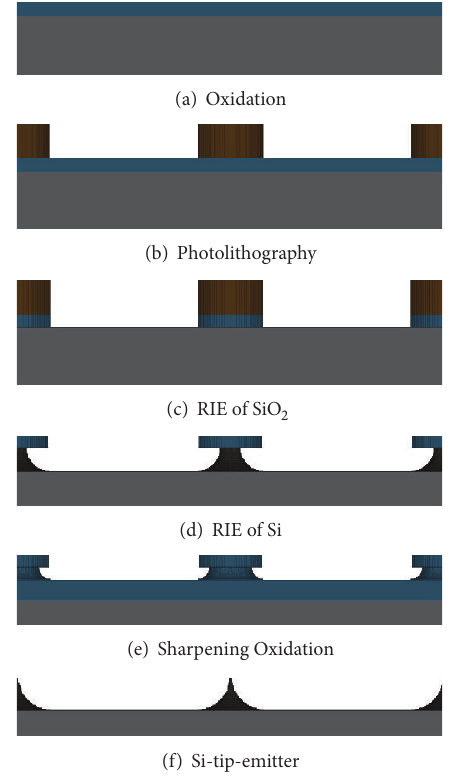
Figure 2: Schematic of the structured cathode fabrication process (simulated with IntelliSuite). (a) Thermal growth of SiO 2 layer. (b) Photolithography with AZ5214. (c) Transferring of the structures into SiO 2 by reactive-ion etching. (d) Reactive-ion etching of the bulk Si. (e) Sharpening of the tips by wet thermal oxidation. (f) Wet chemical removal of SiO 2 .